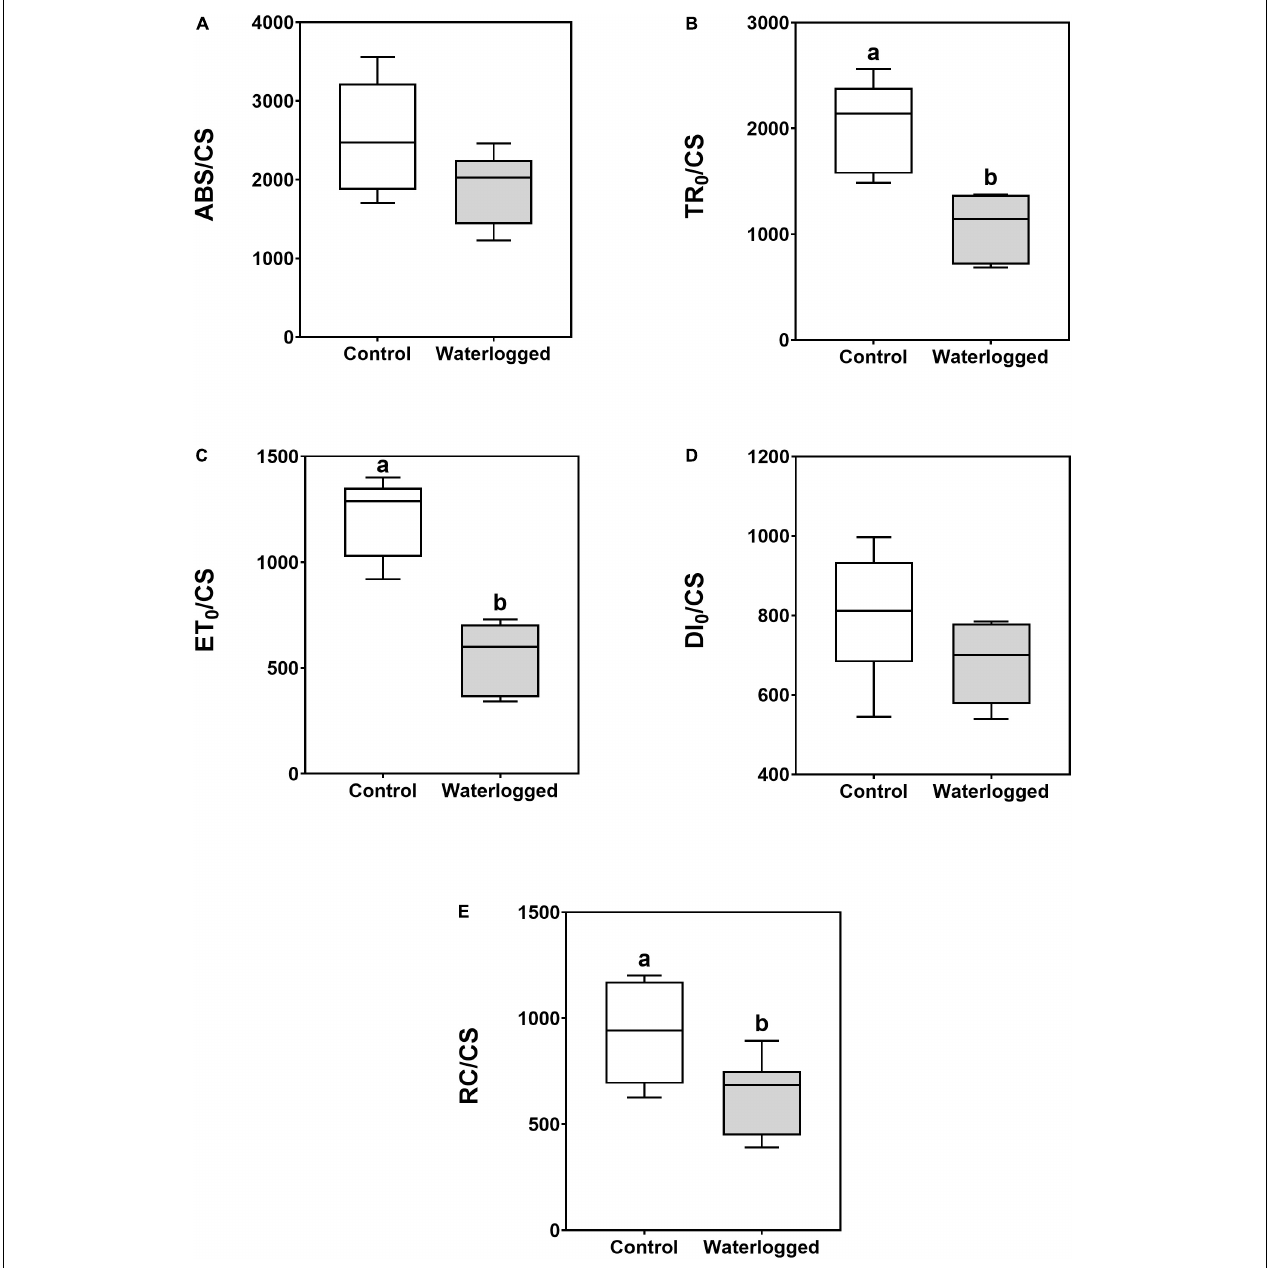
FIGURE 3 | Boxplots of leaf energy fluxes [ A , absorbed (ABS/CS); B , trapped (TR 0 /CS); C , transported (ET 0 /CS); D , dissipated (DI 0 /CS)] and (E) the number of available reaction centers per cross-section (RC/CS) in leaves of control plants (white boxes) and waterlogged plants (gray boxes) of Spartina patens after 30 days ( n = 10, different letters indicate significant differences at p <